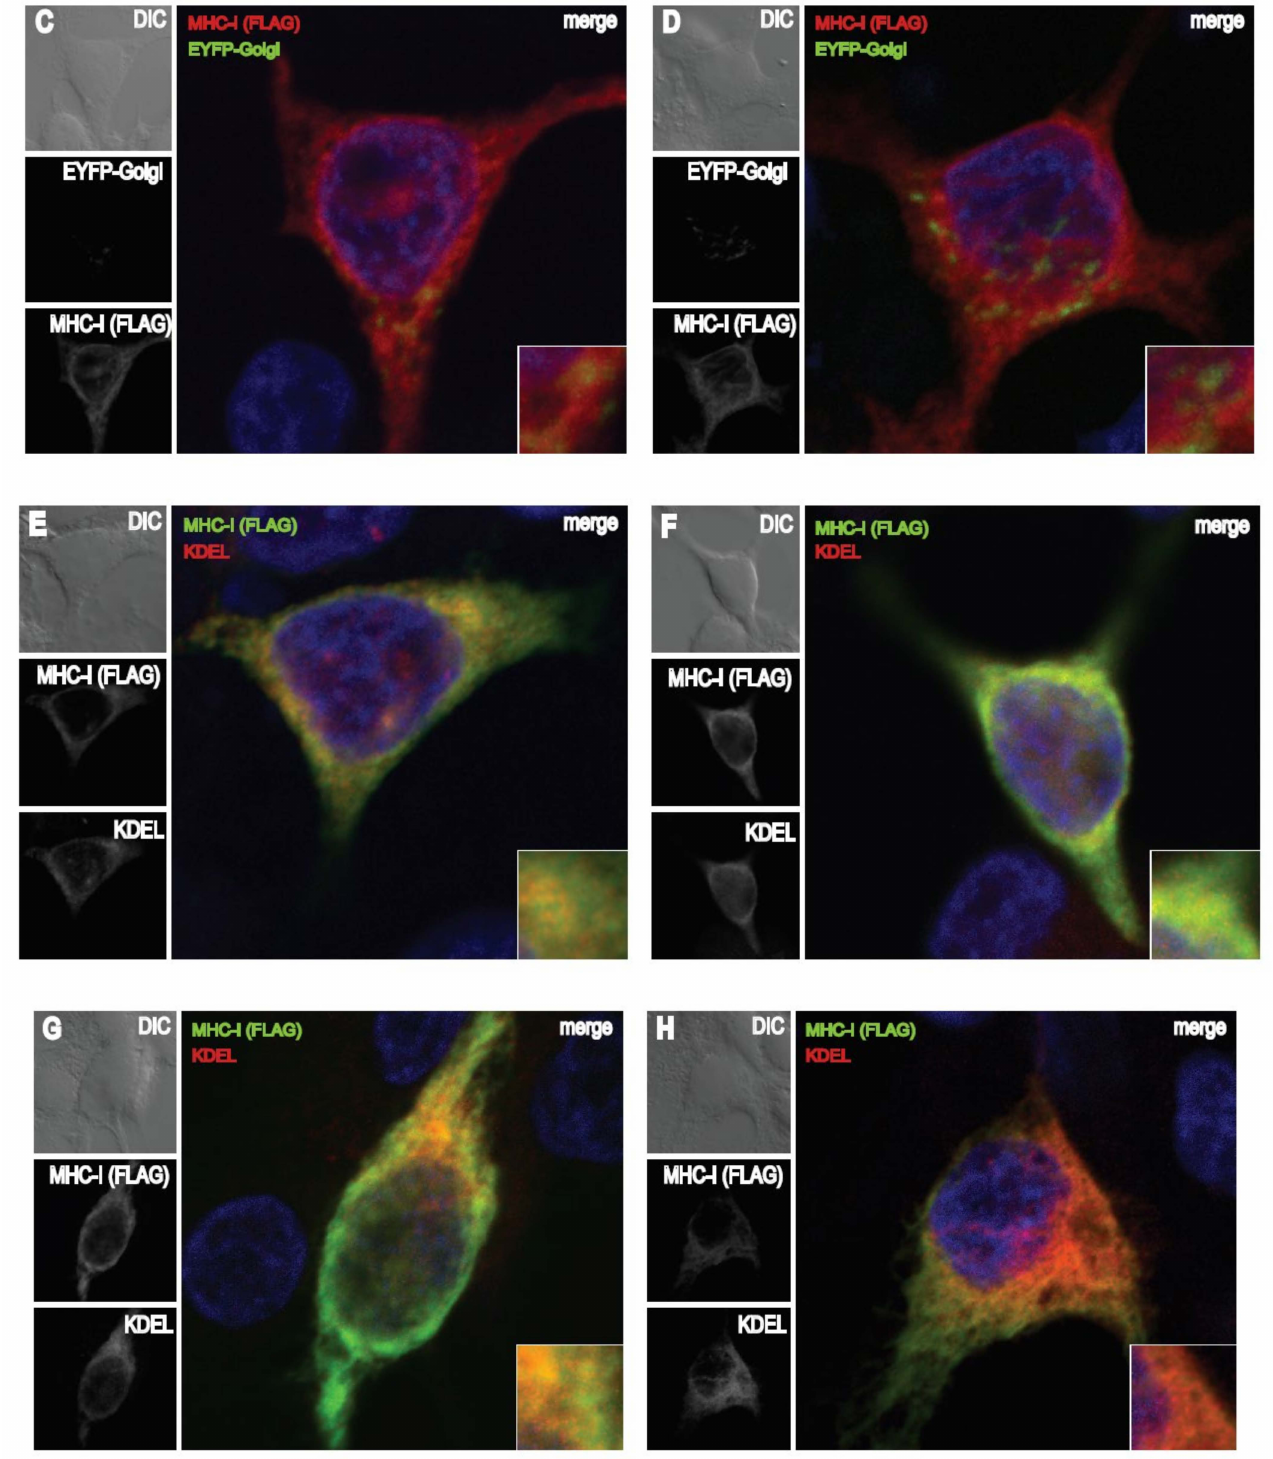
Figure 6. MHC-I localization in infected CH-SAH cells. Cells on coverslips were co-transfected with pFLAG-CMV-MHC- I-B21 and EYFP-Golgi ( A – D ) or with pFLAG-CMV-MHC-I-B21 ( E – H ) and 12 h later were mock infected (( A ) or ( E )) or infected with FAdV-9 ∆ 4 (( B ) or ( F )), wtFAdV-9 (( C ) or ( G )), and rescued viruses (( D ) or ( H )). At 12 h.p.i. cells were fixed, permeabilized, and stained for mouse MAb anti-FLAG M2 ( A – D ) or rabbit anti-FLAG and mouse KDEL ER Marker 10C3 ( E – H ) then stained with Dylight 594 goat anti-mouse ( A – D ) or Dylight 594 goat anti-mouse and Alexa Fluor ® 488 donkey anti-rabbit ( E – H ). All cells were mounted on slides using Prolong Gold Antifade with DAPI. The stained samples were analyzed and imaged by confocal laser scan microscopy using an inverted Leica SP5 microscope with a 63 × glycerol immersion